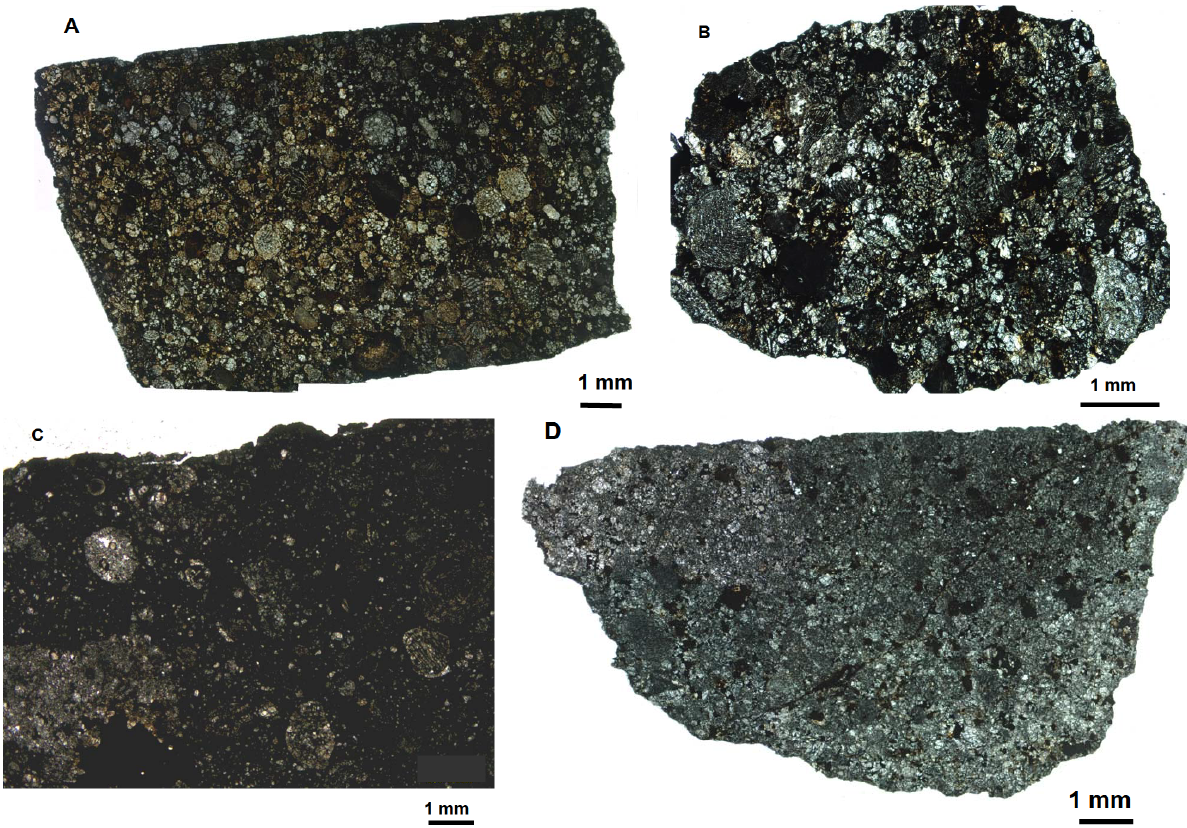
Figure 1. Thin section photos of Mező-Madaras (A), Knyahinya (B), Nyírábrány (C) and Mócs (D)